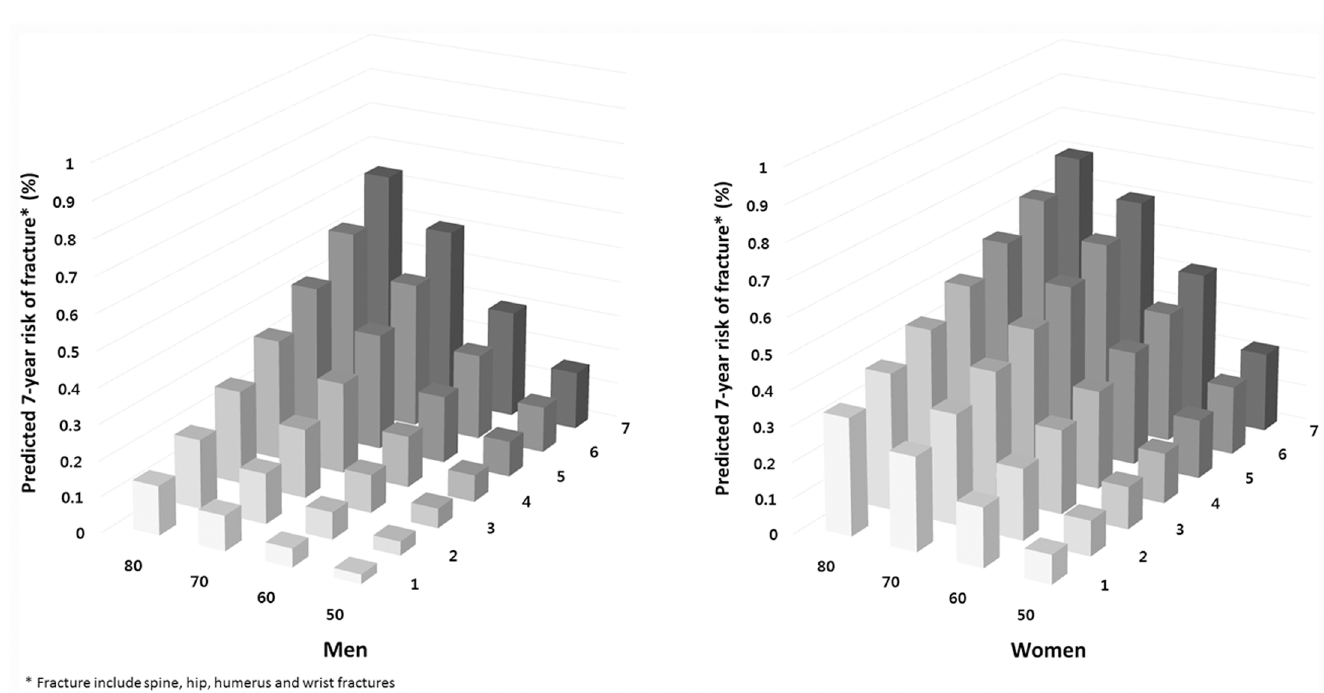
Fig 1. 7- year osteoporotic fracture risk for Koreans according to age and number of risk